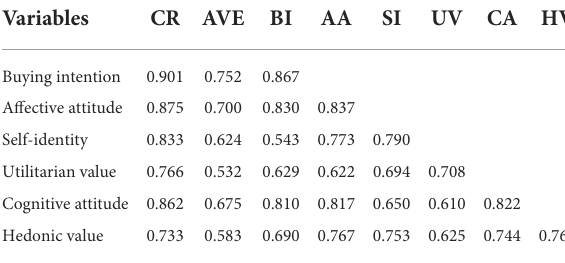
TABLE 5 Discriminant validity discriminant validity of the second-order